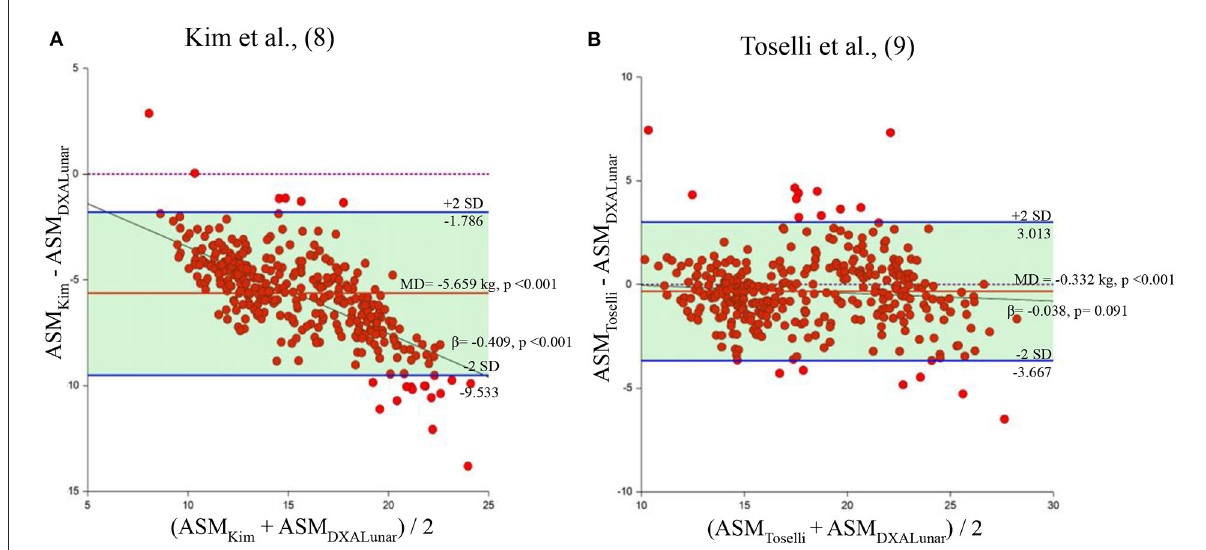
FIGURE1 Bland and Altman plots of the equations generated using DXA Lunar. Behavior of the mean difference against the mean of the measurements between the equations of Kim et al., (8) and Toselli et al., (9) and DXA Lunar. Solid red lines indicate the mean difference. Solid blue lines indicate limits of agreement. Solid black lines indicate the regression line. Dotted line indicates zero. ASM, appendicular skeletal muscle mass; MD, mean of the differences. (A) Kim et al. (8). (B) Toselli et al.